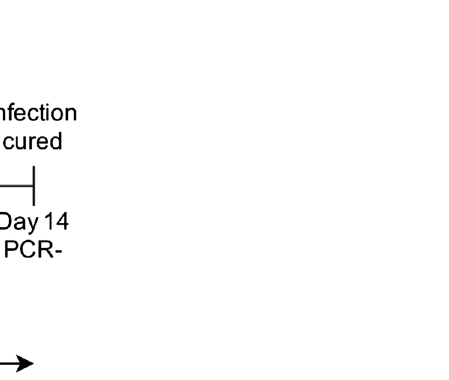
Figure 2. SARS-CoV test interpretation table where we can see if a test can be positive depending on the phase in which the patient is (Instituto de Salud Carlos III).